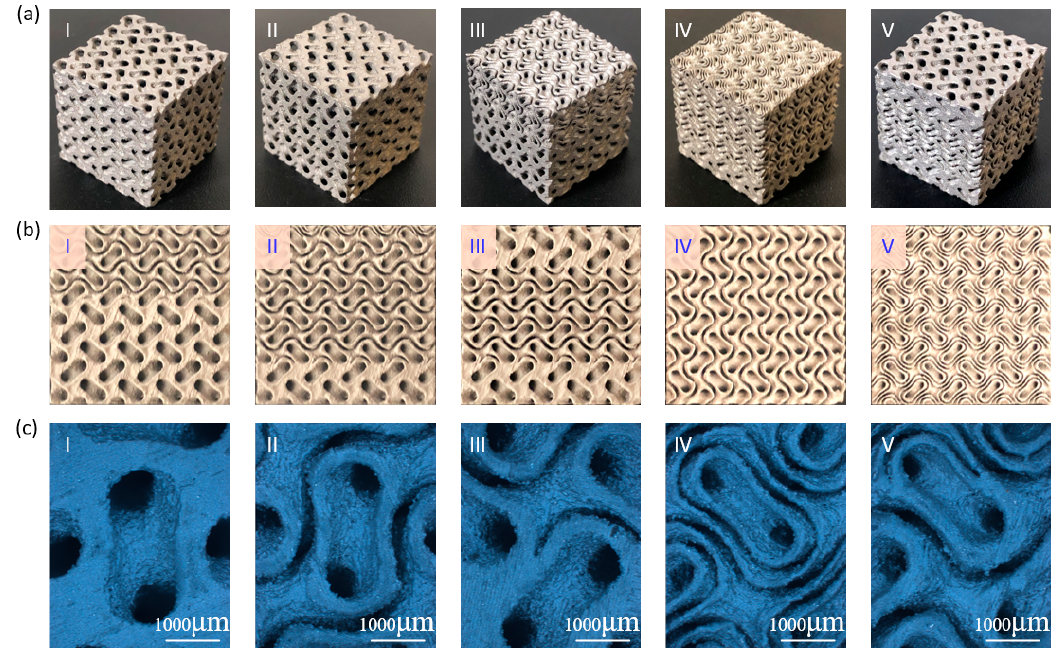
Figure 6. Microstructural characterization of manufactured specimens with different designs: ( a ) fabricated specimens; ( b ) side / top views of the fabricated parts; and ( c ) close-up views of the surfaces.